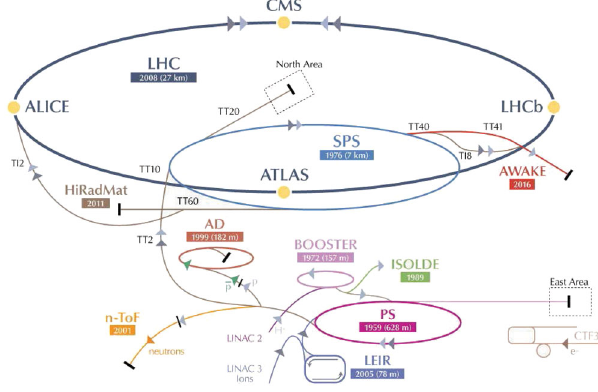
FIG. 1. CERN ’ s accelerator complex